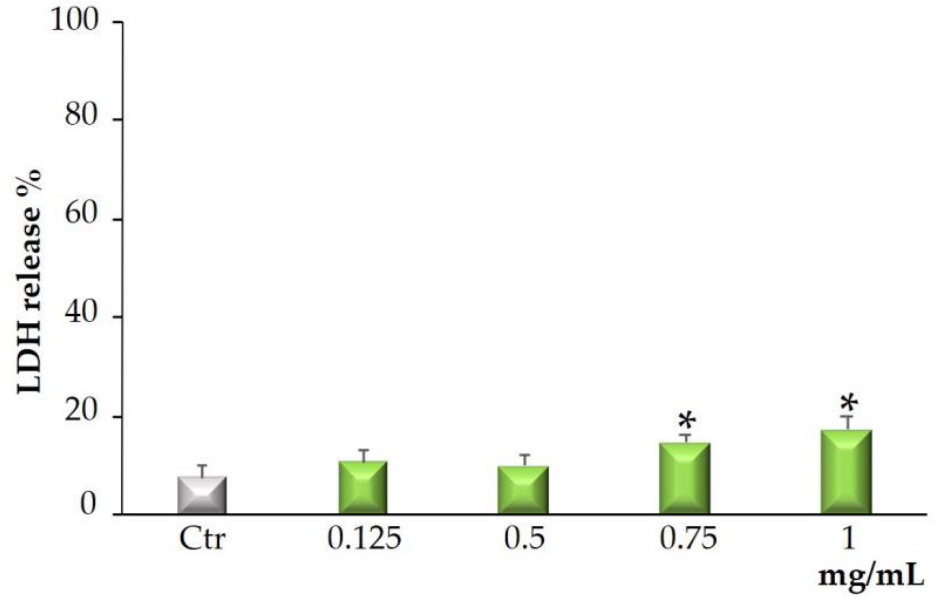
Figure 4. LDH released in CaCo-2 cells untreated and treated for 72 h with Bff -EAF at different concentrations (0.125–1 mg/mL). Values are the mean ± SD of four experiments in triplicate. * Significant vs. untreated control cells: p < 0.001.